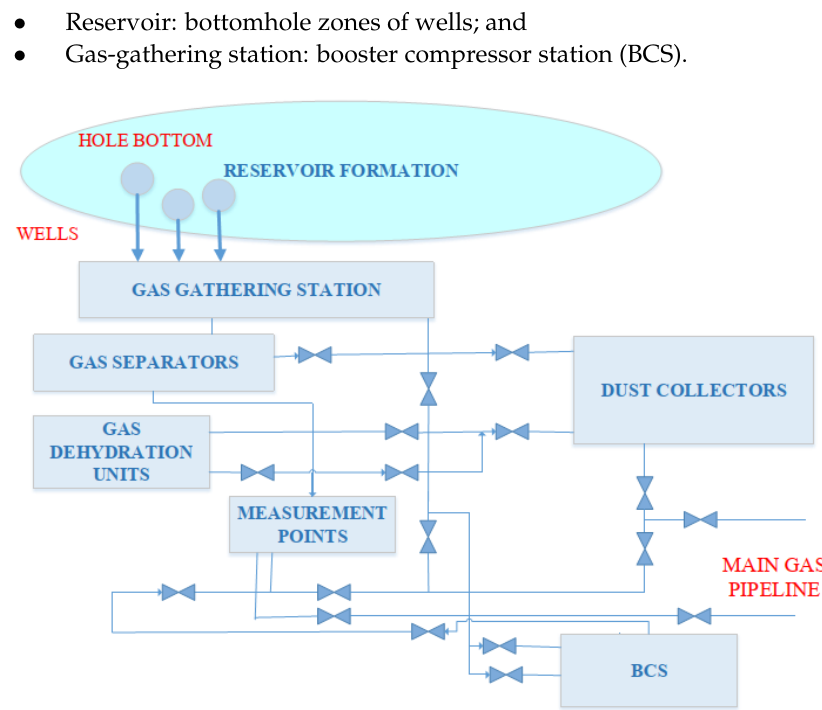
Figure 1. Schematic representation of the piping and instrumentation diagram of underground gas storage.